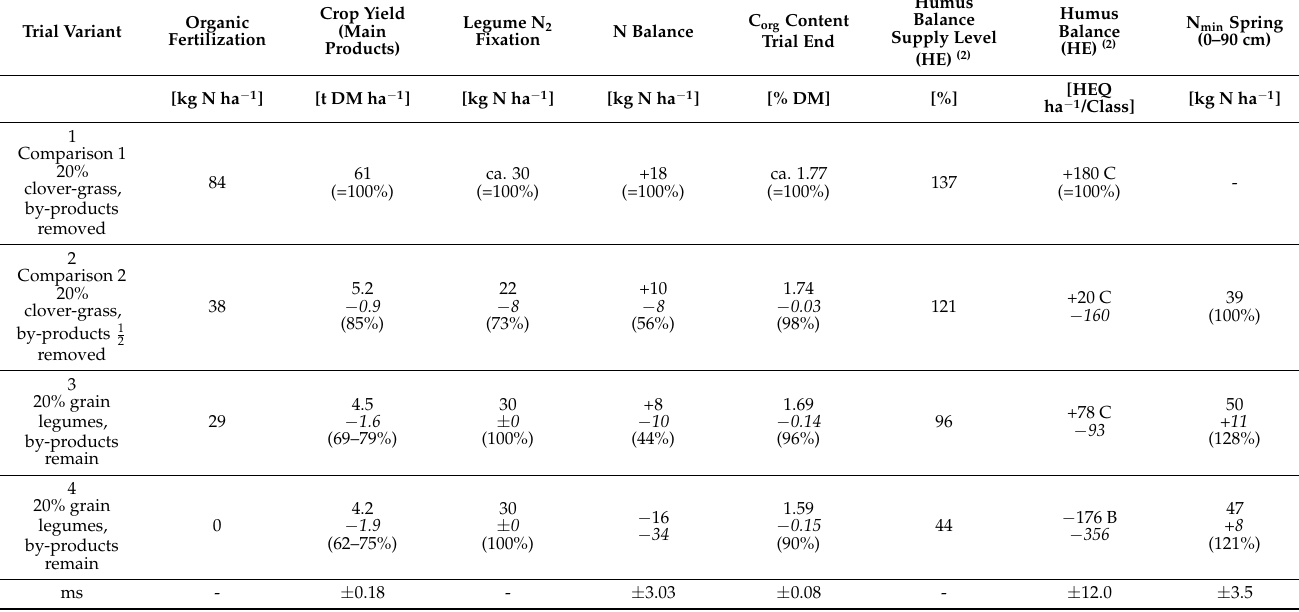
Table 6. Mean values, absolute (italics) and relative (in parentheses) change compared to a medium intensity [comparison 1 = 100%, see Table 2] or low livestock-less intensity [comparison 2, see Table 3], and supply classes (1) of some important characteristics of fertilization and soil fertility in market crop systems with 20% rotation share of legumes from clover-grass or grain legumes from long-term trials on loamy